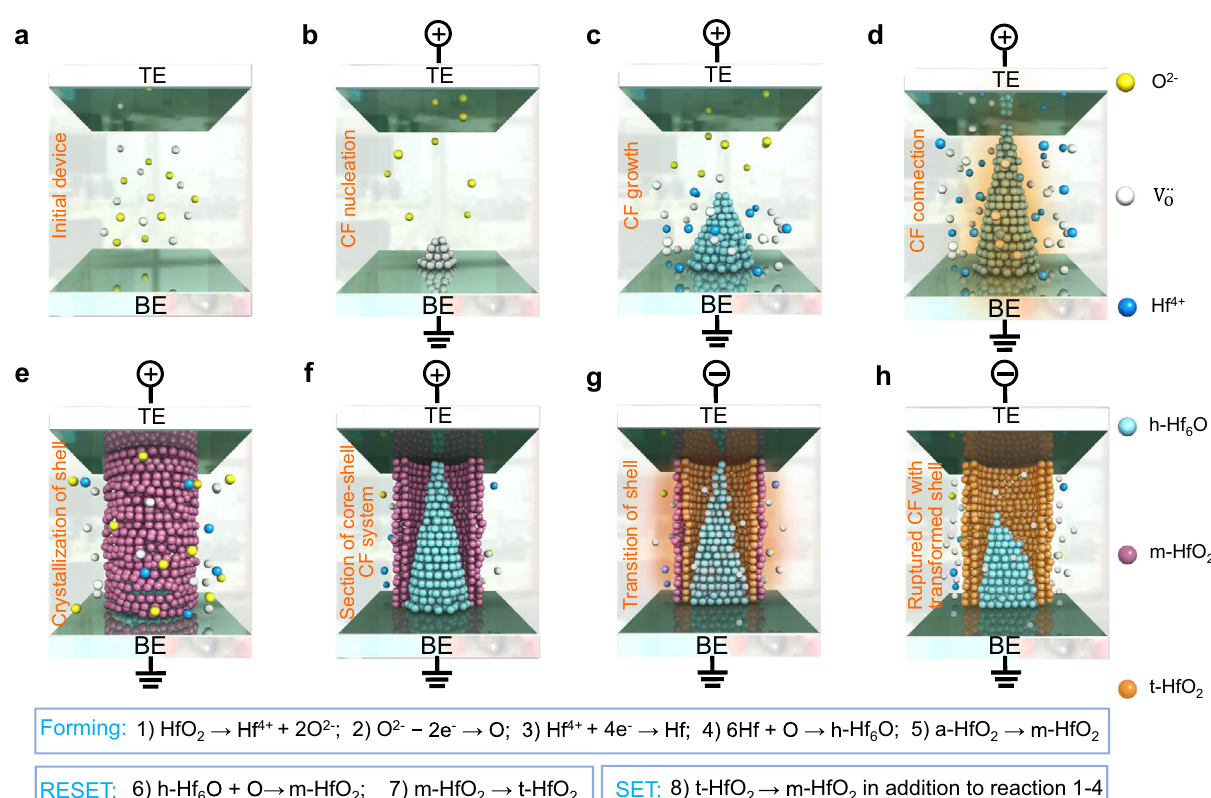
Fig. 5 Schematic illustration of the CF system evolution in Pt/HfO 2 /Pt memristor. a Initial state of the device. b Under a positive electric fi eld, dissociated O 2 − ions from HfO 2 are generated near the BE and move from the BE to the TE, resulting in localized oxygen depletion. c Growth of Hf-rich or O-vacancy CFs in the RS layer. d The as-grown CF bridge and the annealing effect of Joule heat generated by the high current. e The as-formed quasi-core-shell CF system consists of conductive h-Hf 6 O and the surrounding nonconductive monoclinic HfO 2 (m-HfO 2 ) shell. f Longitudinal-section view of the core-shell CF system. g Transition of the surrounding m-HfO 2 shell into t-HfO 2 driven by the high current through the Hf 6 O CF in the RESET process. h Ruptured h-Hf 6 O CF and its t-HfO 2